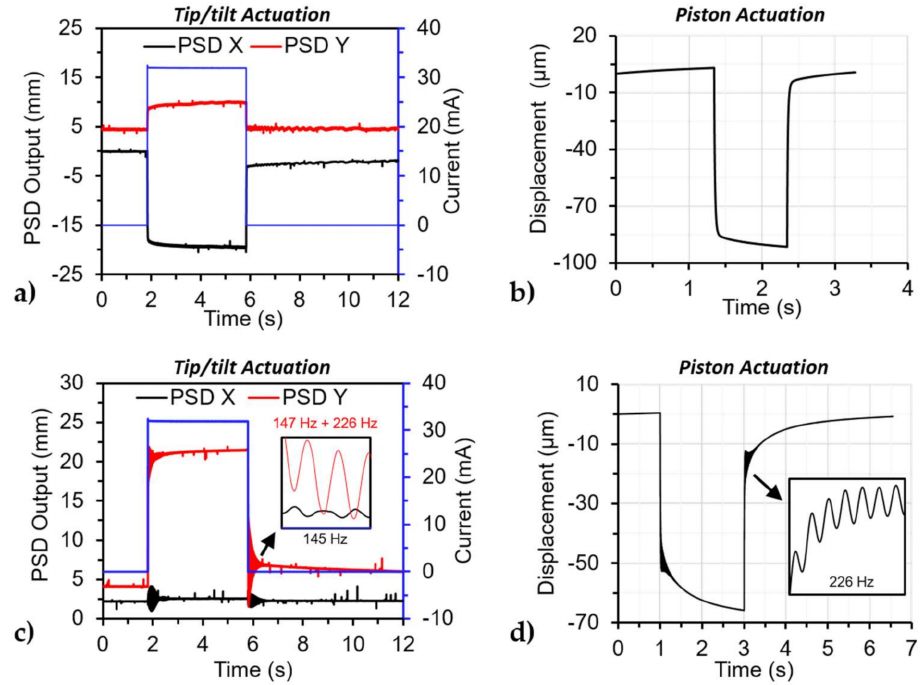
Figure 8. Step response for the undercarriage and the mirror-bonded device: ( a ) Tip/tilt motion for the undercarriage (top actuator), ( b ) piston motion for the undercarriage (right actuator), ( c ) tip/tilt motion for the mirror-bonded with an inset of a close-up look at the oscillation after the input reach 0 mA, and ( d ) piston motion for the mirror-bonded device with an inset of a zoom in of the